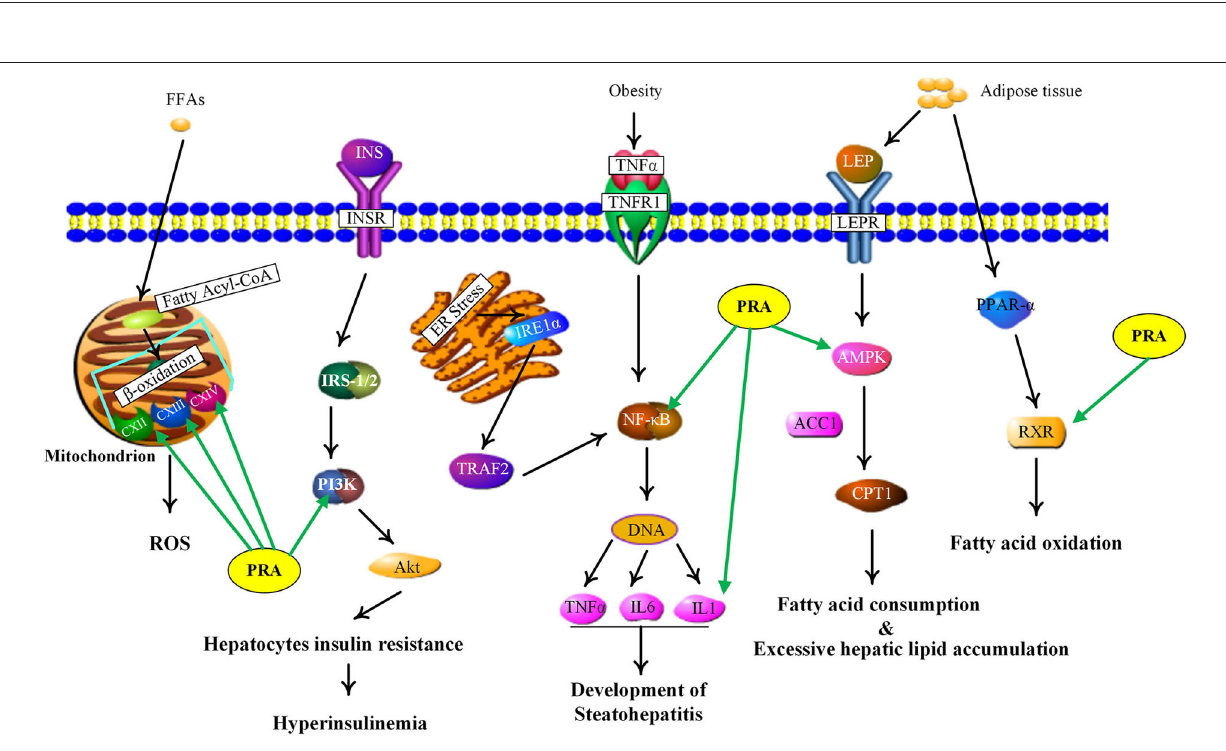
FIGURE 5 | NAFLD signaling pathway influenced by major putative targets of PRA